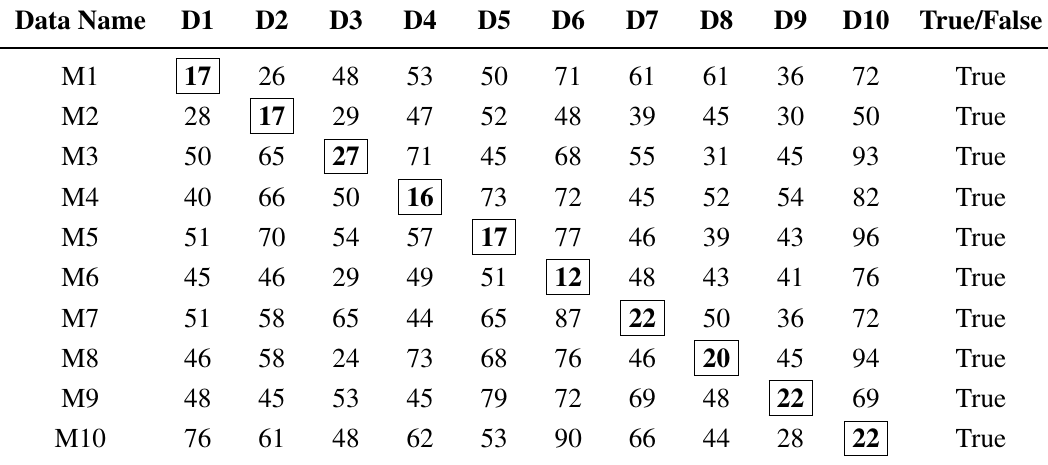
Table 2. Voting results for 10 measured data. M1 ∼ M10 represent the 10 measured data. D1 ∼ D10 represent the 10 samples in the database. The number in the frame is the minimum number in each row. True/False represents the current identification is true or